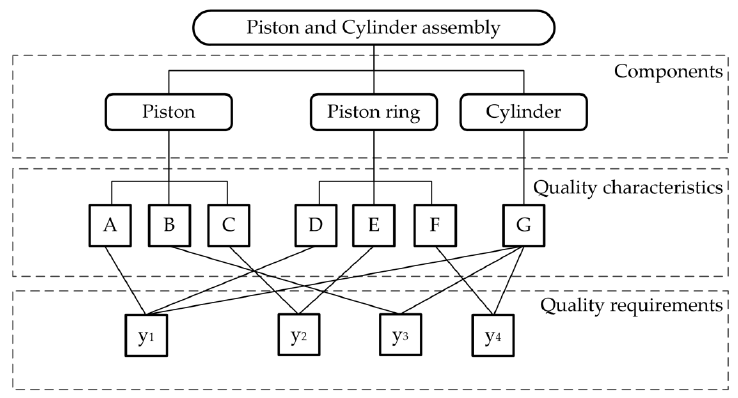
Figure 5. Piston cylinder assembly structure and QRs.